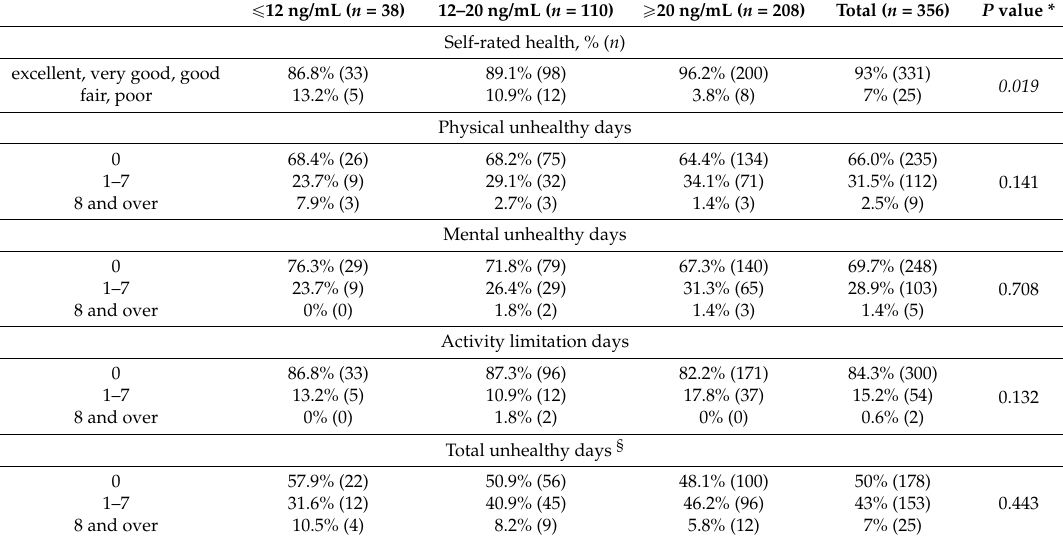
Table 2. HRQOL-4 components across 25(OH)D (ng/mL)